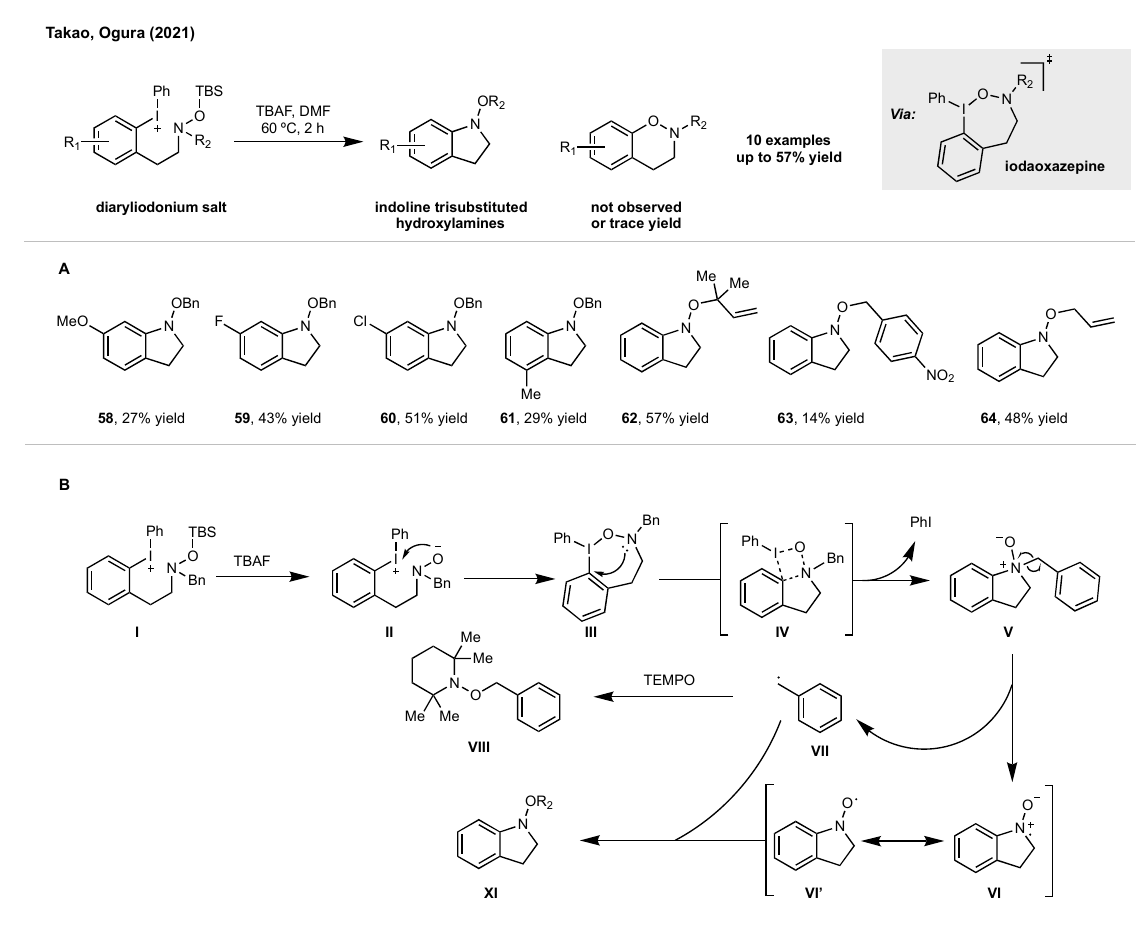
Scheme 6. Takao and Ogura(cid:31)s synthesis of indoline trisubstituted hydroxylamines. ( A ) Selected ex- amples of the transformation. ( B ) Proposed mechanism